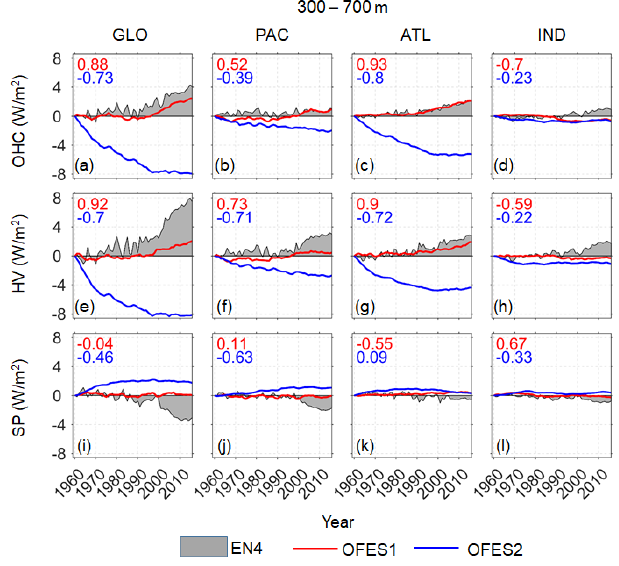
Figure 3. As for Fig. 2 but for the middle layer